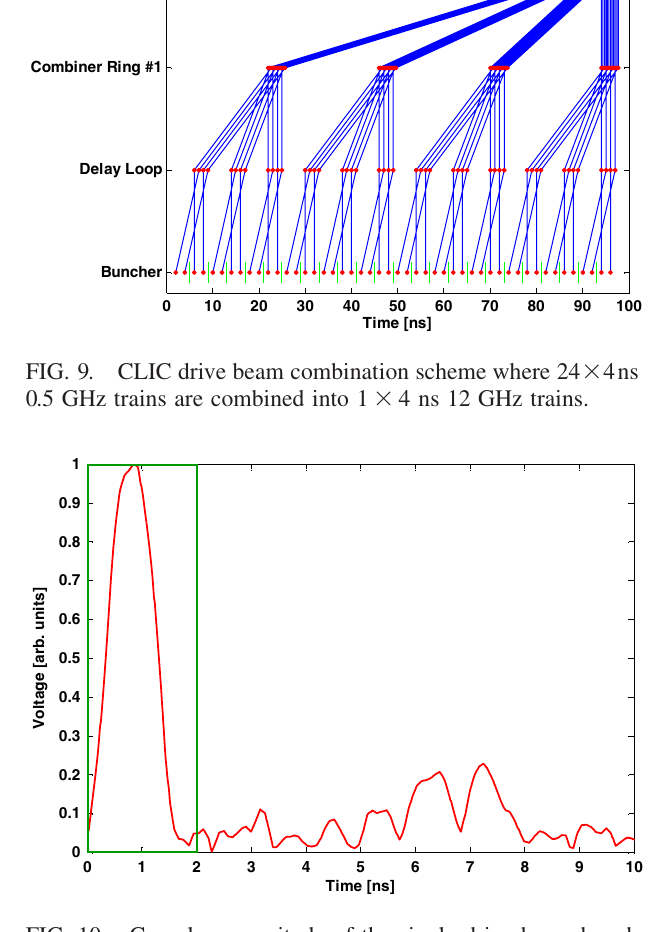
FIG. 10. Complex magnitude of the single drive beam bunch response.